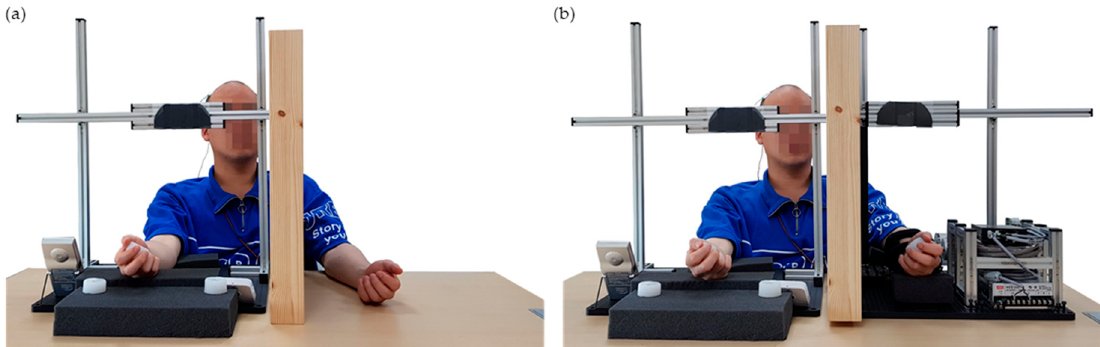
Figure 5. ( a ) Conventional mirror therapy (CMT) experimental setup. ( b ) The continuous passive motion mirror therapy (CPM − MT) system experimental setup.